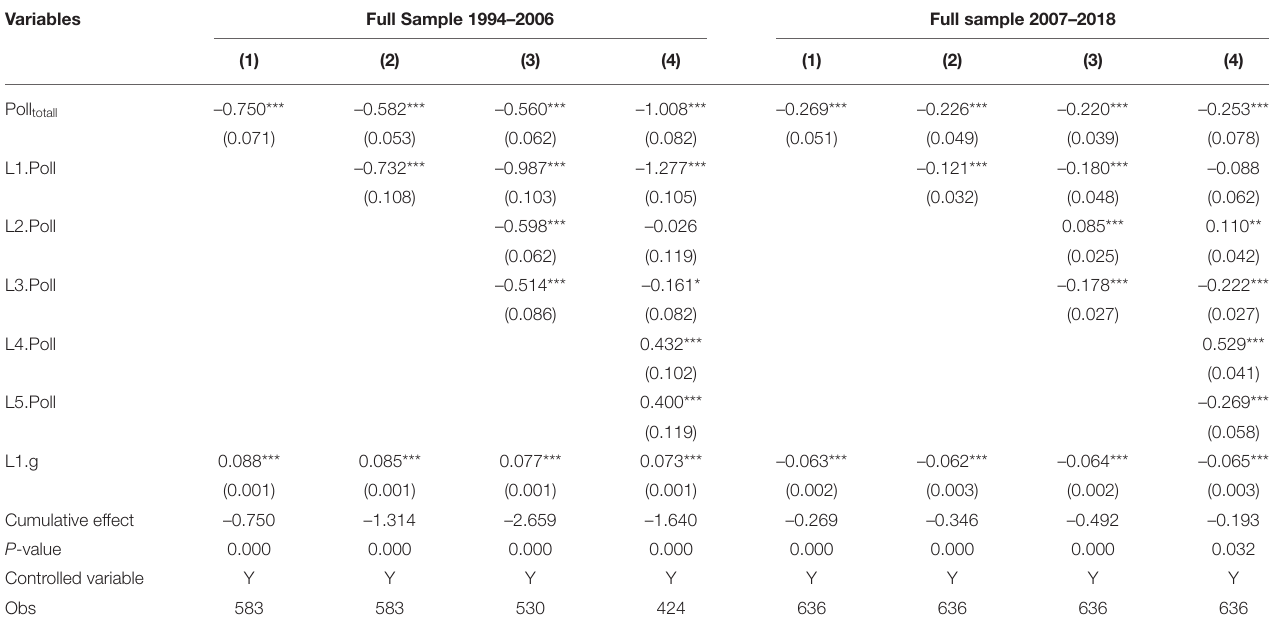
TABLE 8 | Estimated results by time